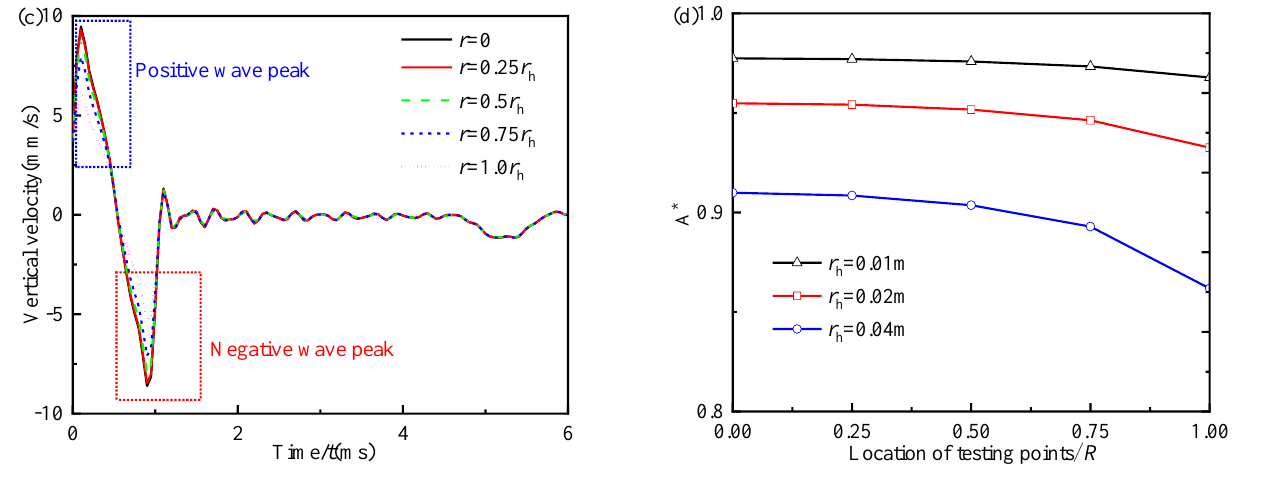
= 0.01 m; ( b ) r = 0.02 m; ( c ) r = 0.04 m; ( d ) Variation h h h